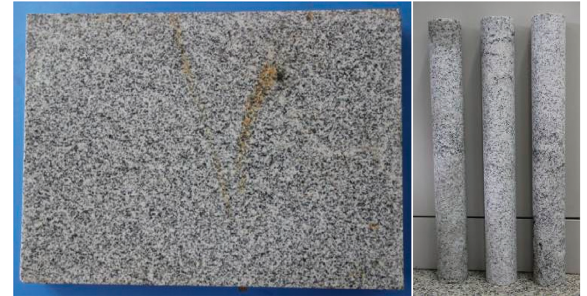
Figure 2: Whole rock block and specimens cut for the